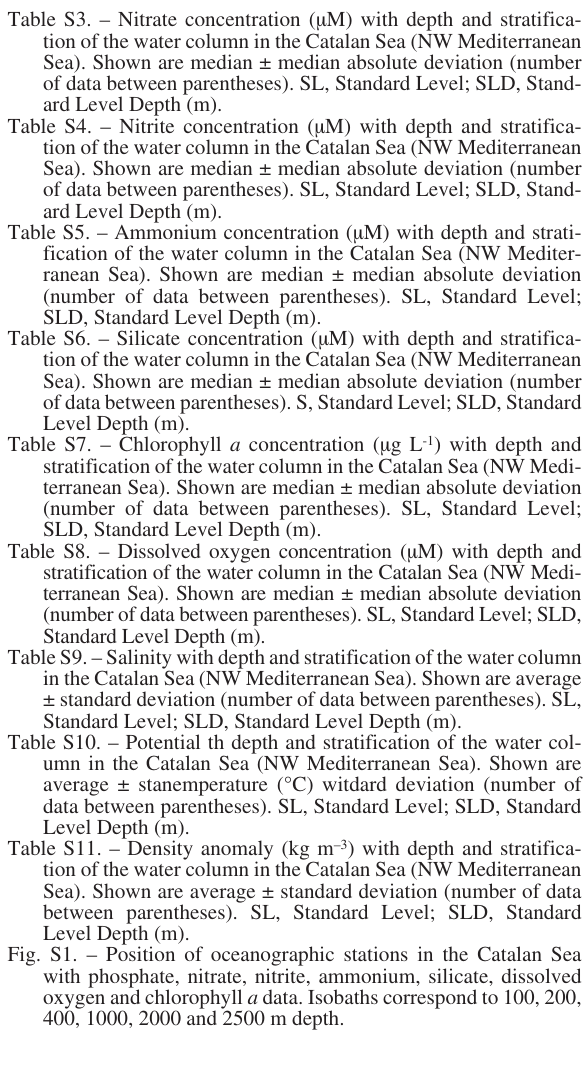
Table S3. – Nitrate concentration (µM) with depth and stratifica- tion of the water column in the Catalan Sea (NW Mediterranean